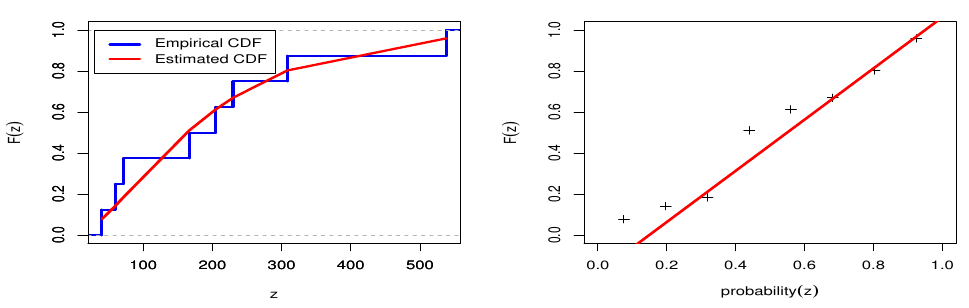
Figure 6. Empirical CDF and P-P plots for the EED for dataset